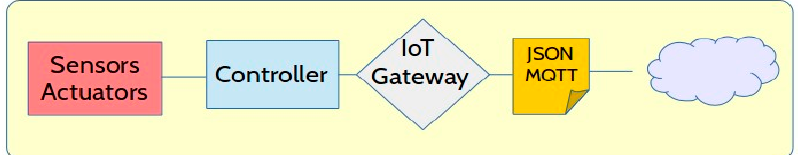
Figure 14. Publishing gate data to the cloud.